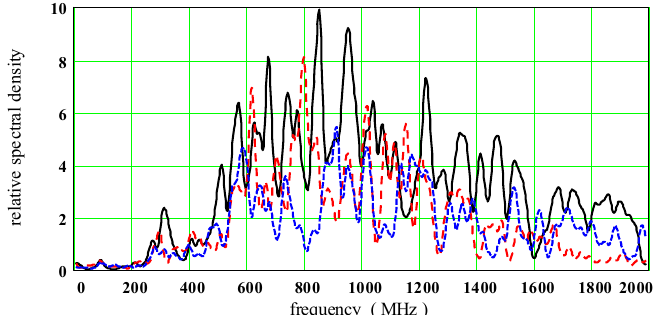
gle PD pulse in the 18 MVA transformer. PD pulse in the 18 MVA transformer.